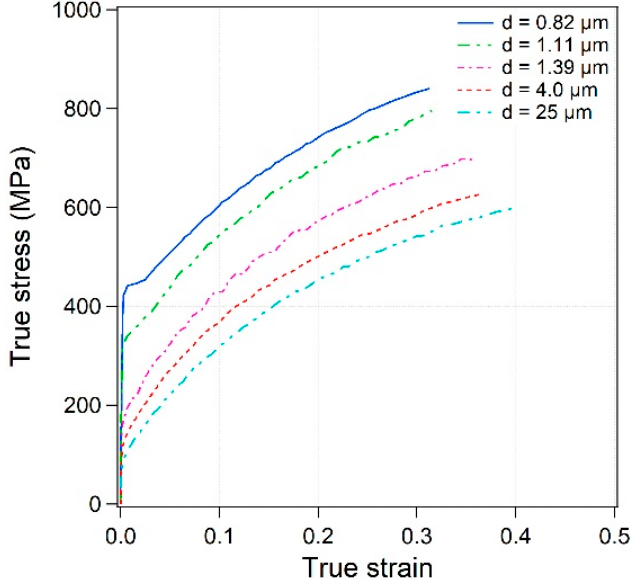
Figure 2. True stress–true strain tensile curves for Ni samples 1–5 processed by spark plasma sintering (SPS).